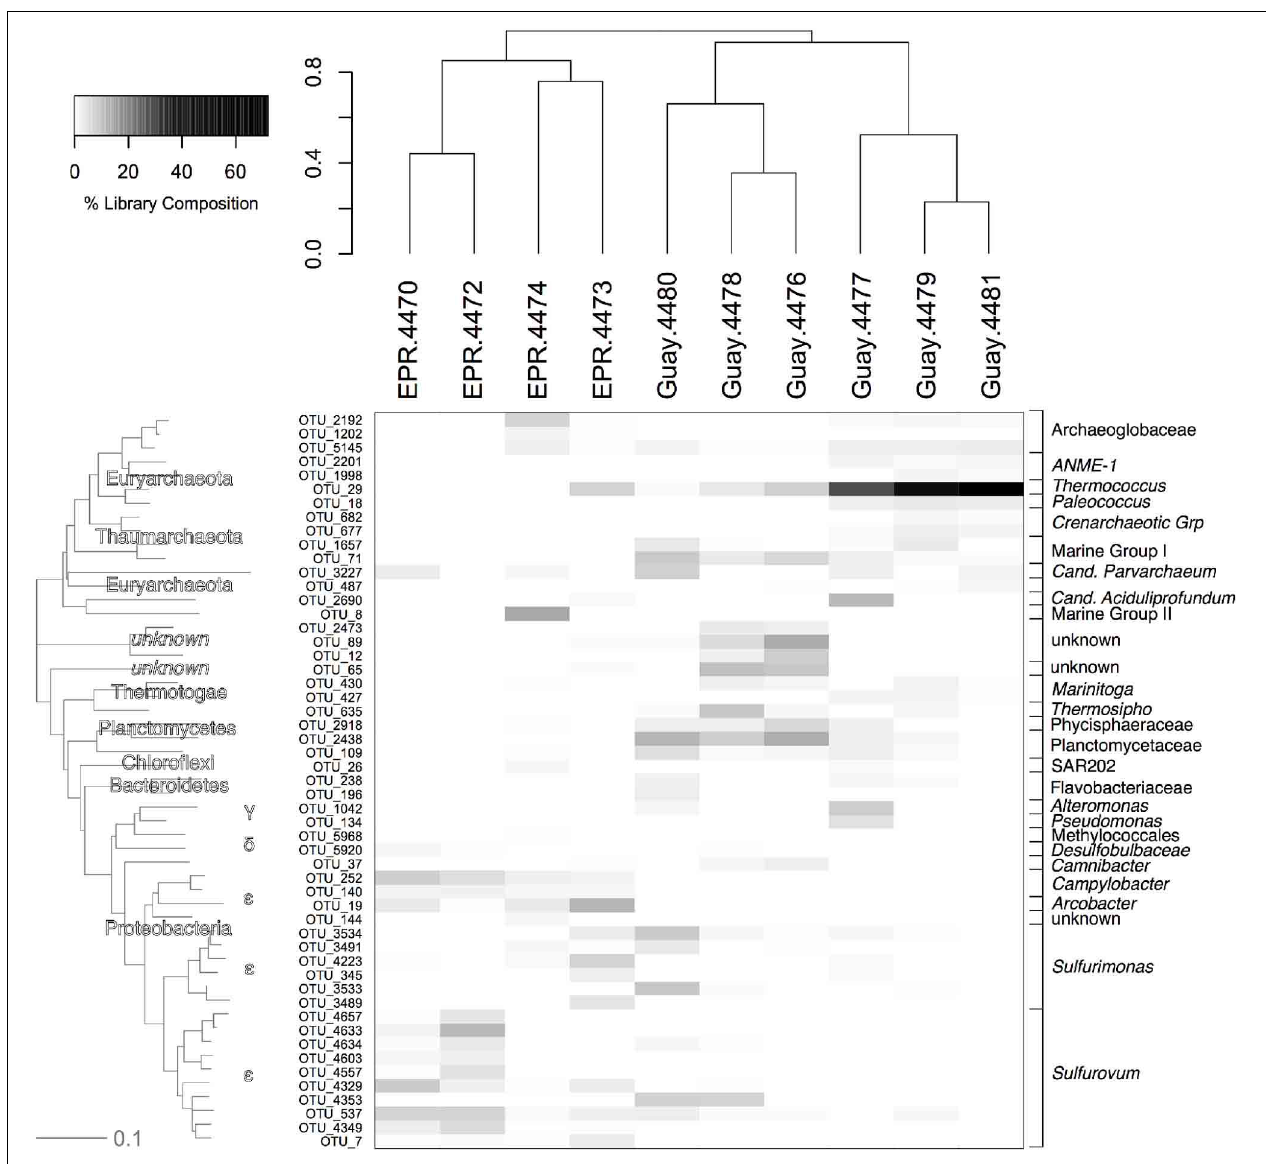
FIGURE 6 | Relative abundance of OTUs from the vent-specific microbial community of the indicated sample with their corresponding phylogenetic affiliation. Sample communities were clustered with a Bray-Curtis similarity measurement based on relative